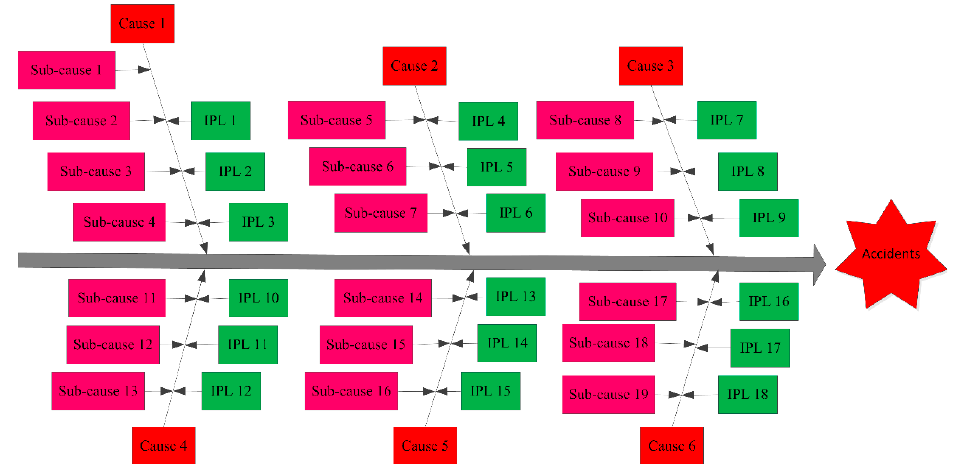
Figure 4. Cause and effect–LOPA of dangerous and harmful factors.